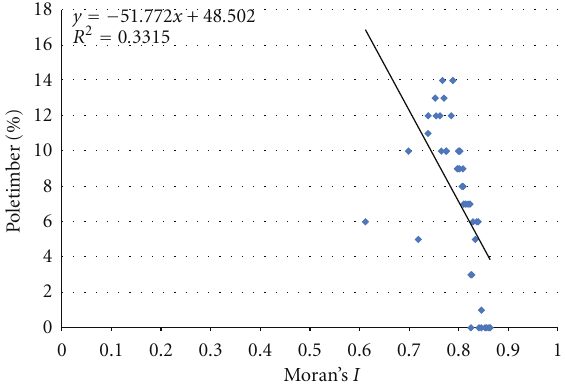
Figure 17: Moran’s I versus poletimber (bounds excluded).